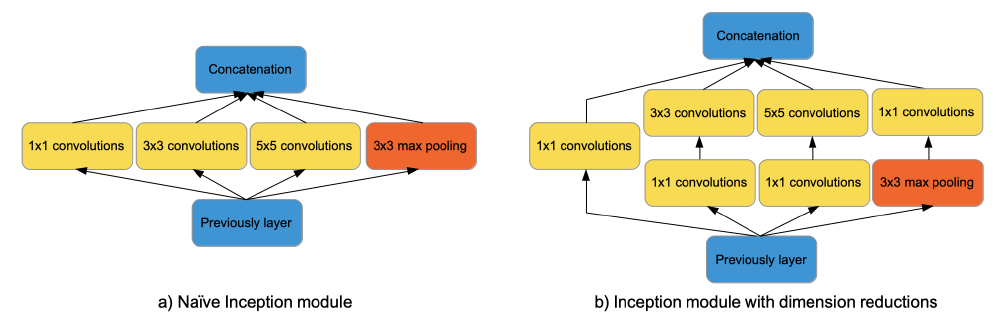
Figure 1. Inception-V1 modules. On the left side, the naïve Inception module consisting of a pooling layer and convolution filters of size 1 × 1, 3 × 3, 5 × 5. On the right side, the Inception module with dimension reductions obtained adding convolutions of size 1 ×